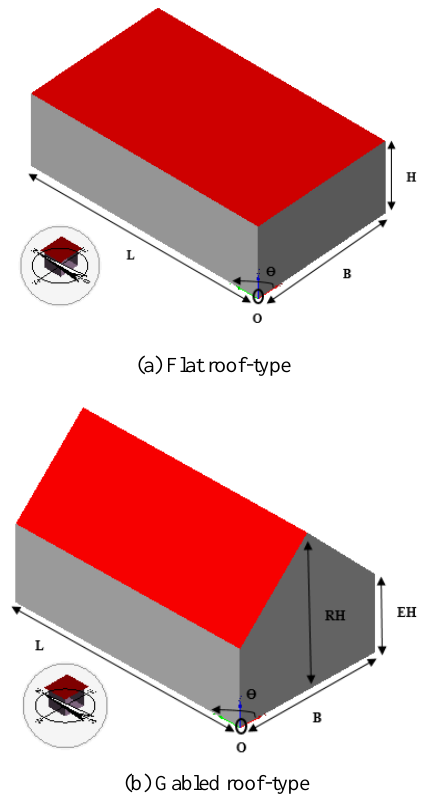
Figure 2. Test cases for uncertain geometry generation